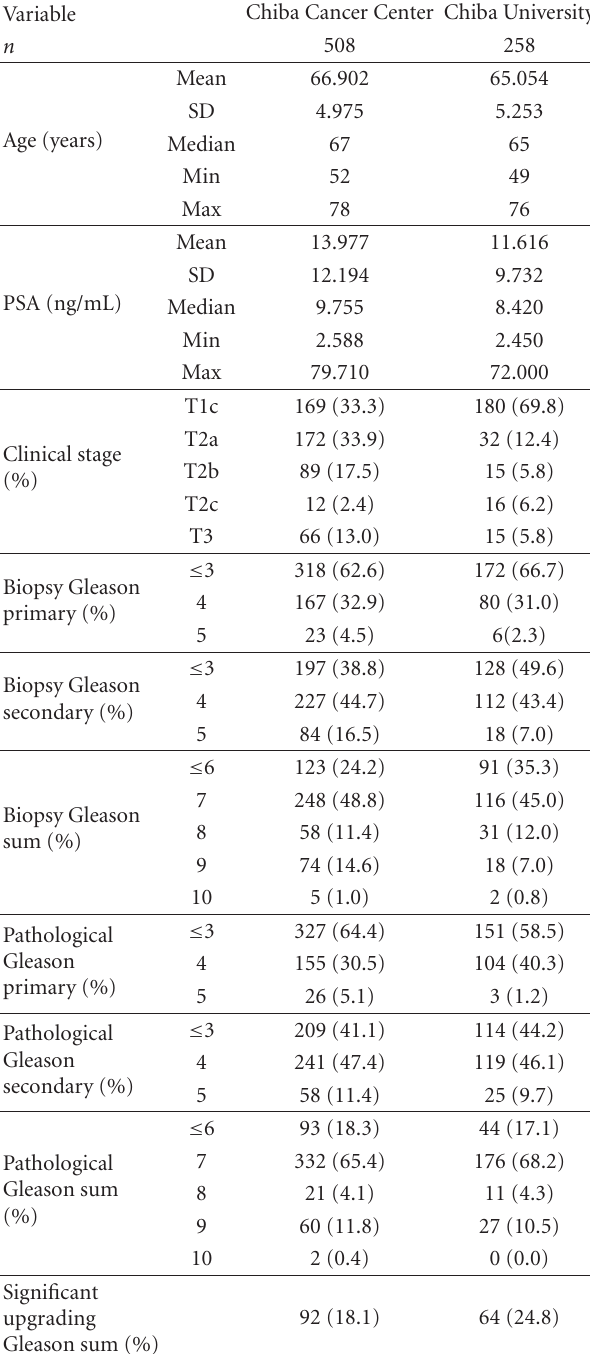
Table 1: Descriptive characteristics of subgroups according to institutions.